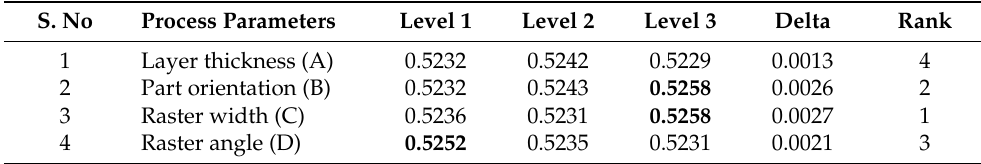
Figure 9. Mean closeness coefficients for FDM process parameters. Table 7. Mean closeness coefficient for process